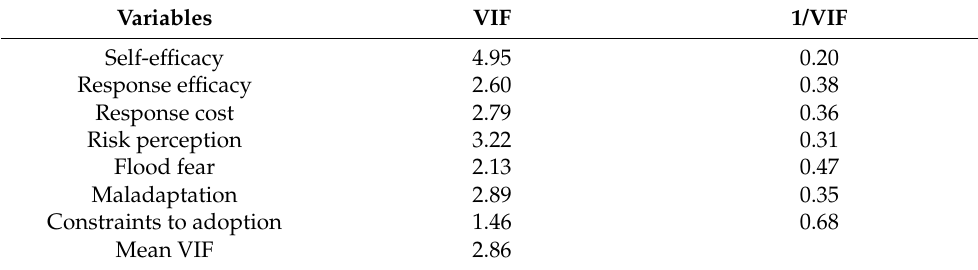
Table 4. Results of multicollinearity testing.